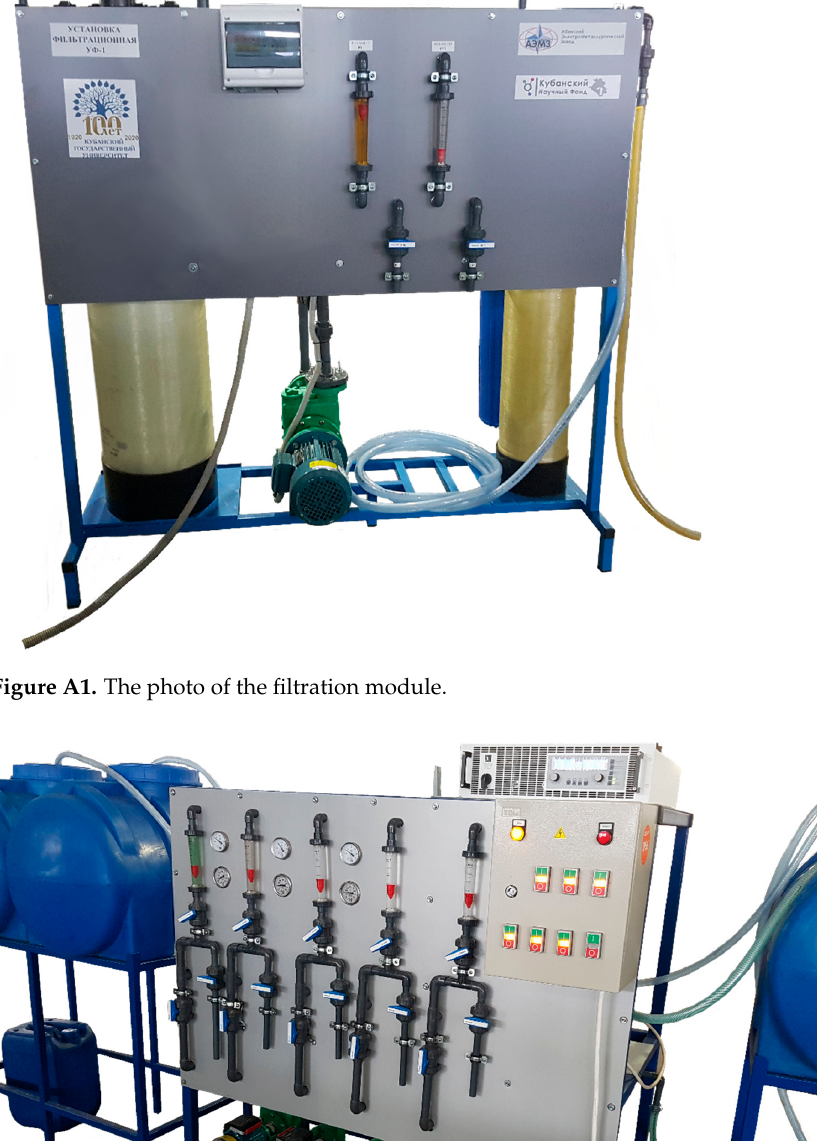
Figure A2. The photo of the pilot scale hybrid installation.